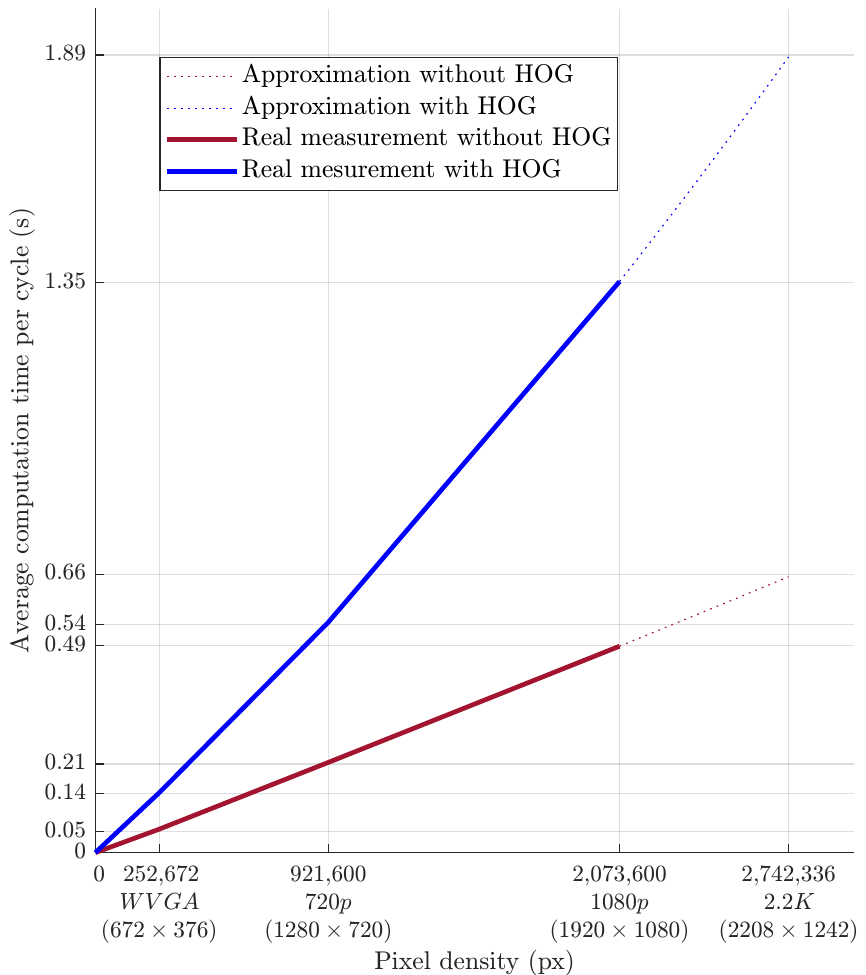
Figure 18. Dependence of the average computational time per cycle on the pixel